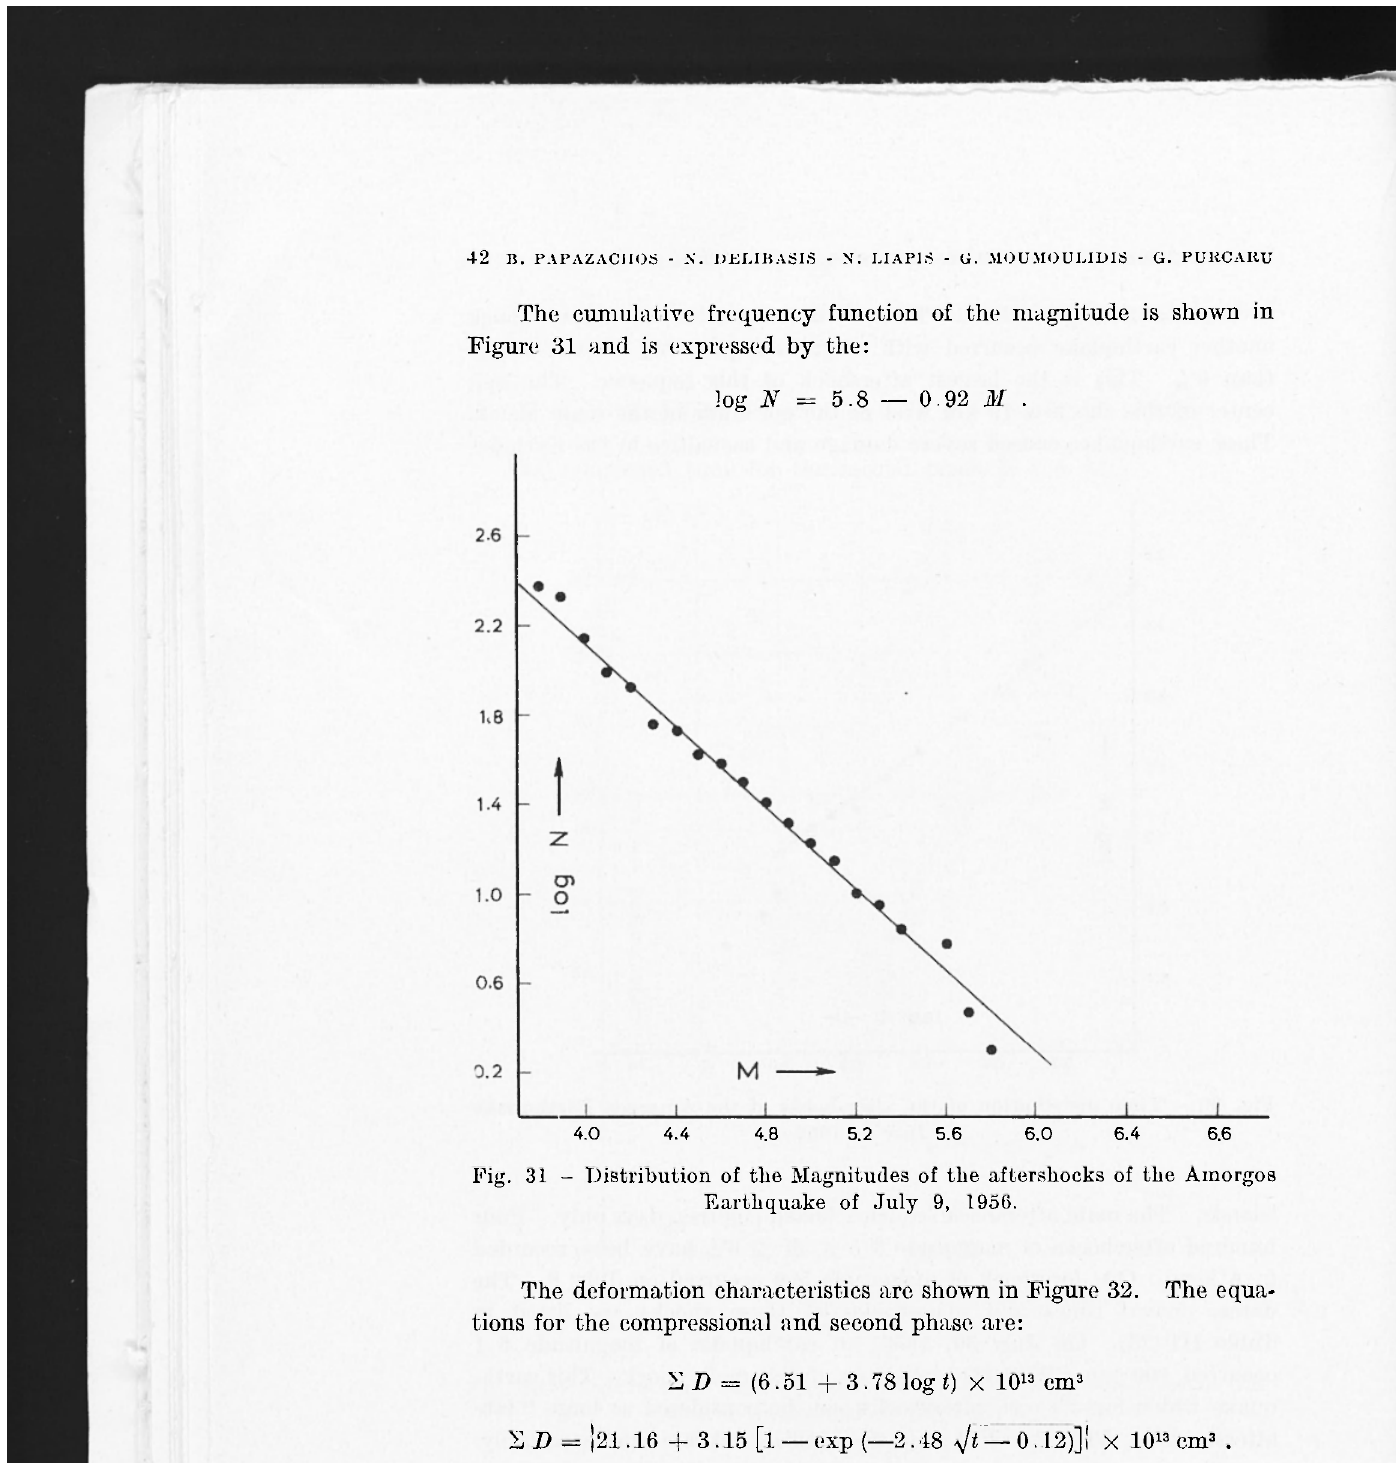
Fig. 31 - Distribution of tlae Magnitudes of the aftershocks of the Amorgos Earthquake of July 9,